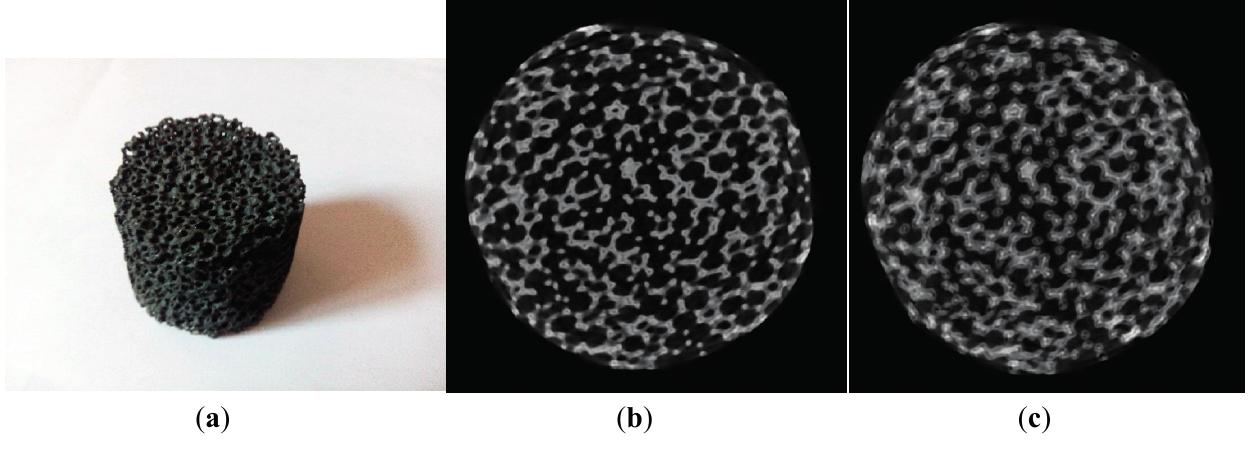
Figure 8. Scanned sample and the middle slice of the volume data. ( a ) SiC sample; ( b ) the middle slice after system adjustment; ( c ) the middle slice before system